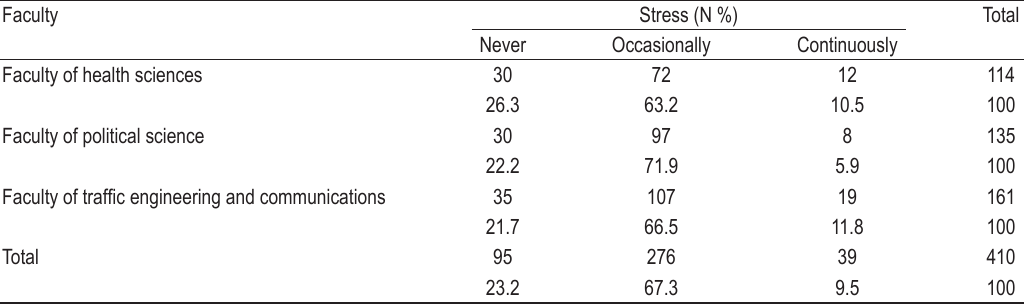
TABLE 6. Stress experience in students from three groups